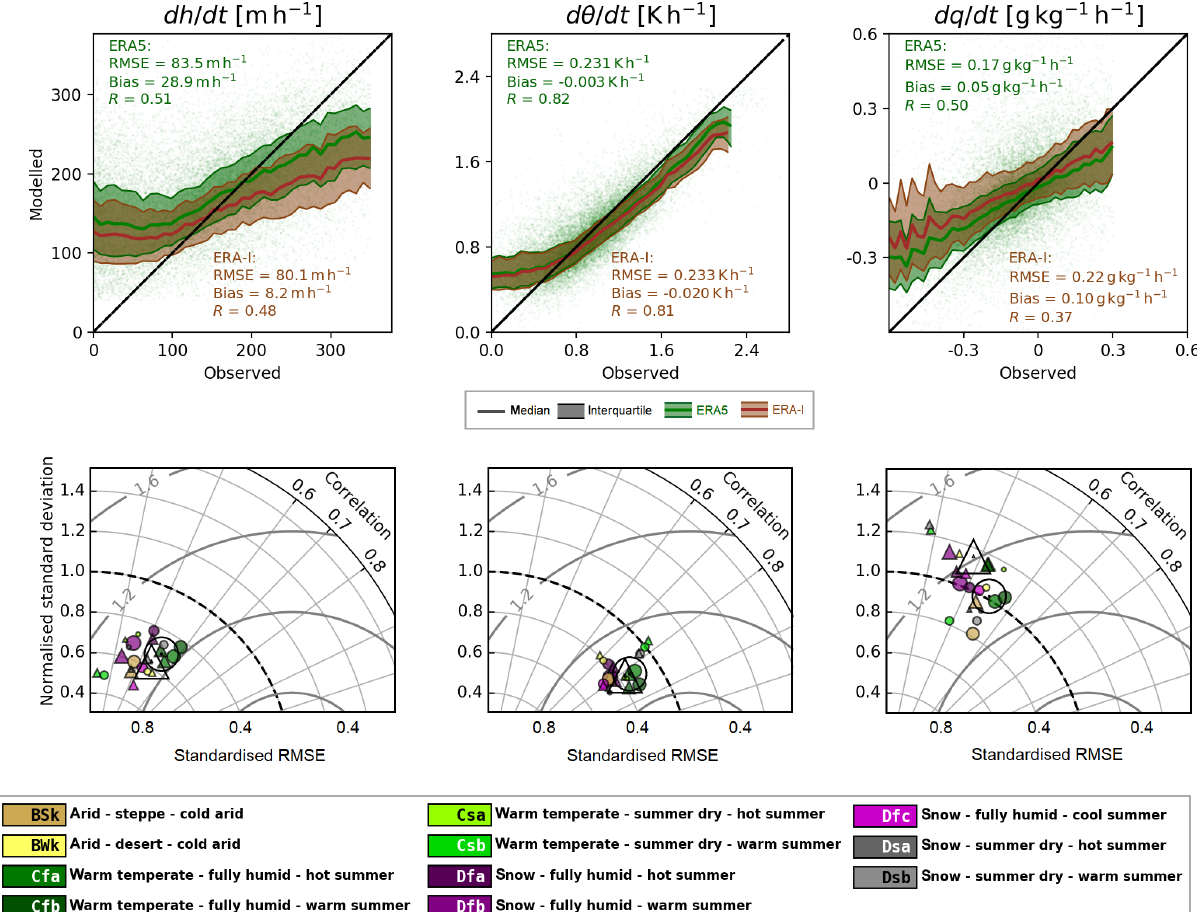
Figure 10. Skill of CLASS4GL at reproducing diurnal changes in ABL properties when forced with surface evaporative fractions from ERA5 vs. ERA-I. Shown are the tendencies of the mixed-layer height (d h/ d t ), potential temperature (d θ/ d t ), and specific humidity (d q/ d t ), which are assessed by comparison of model simulations against the IGRA sounding data between 1981 and 2015. The first row shows modelled vs. observed data points, and the corresponding median and interquartile range of the simulations in solid lines, where green represents ERA5 and brown ERA-I. The 1–1 line is shown as a black line for reference. The bottom row illustrates the skill of the ABL simulations when forced with ERA5 (circles) vs. ERA-I (triangles) in the form of Taylor plots. The transparent symbols show the overall performance of 18000 sounding pairs from 121 stations, whereas the coloured symbols indicate the performance per Köppen–Geiger climate class and for which the size is proportional to the number of sounding